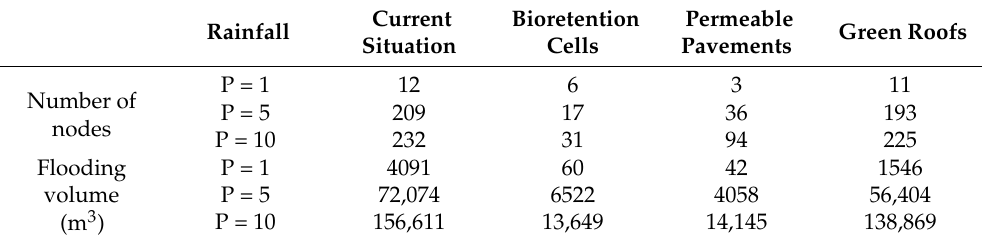
Table 6. Waterlogging with different rainfall events and LID